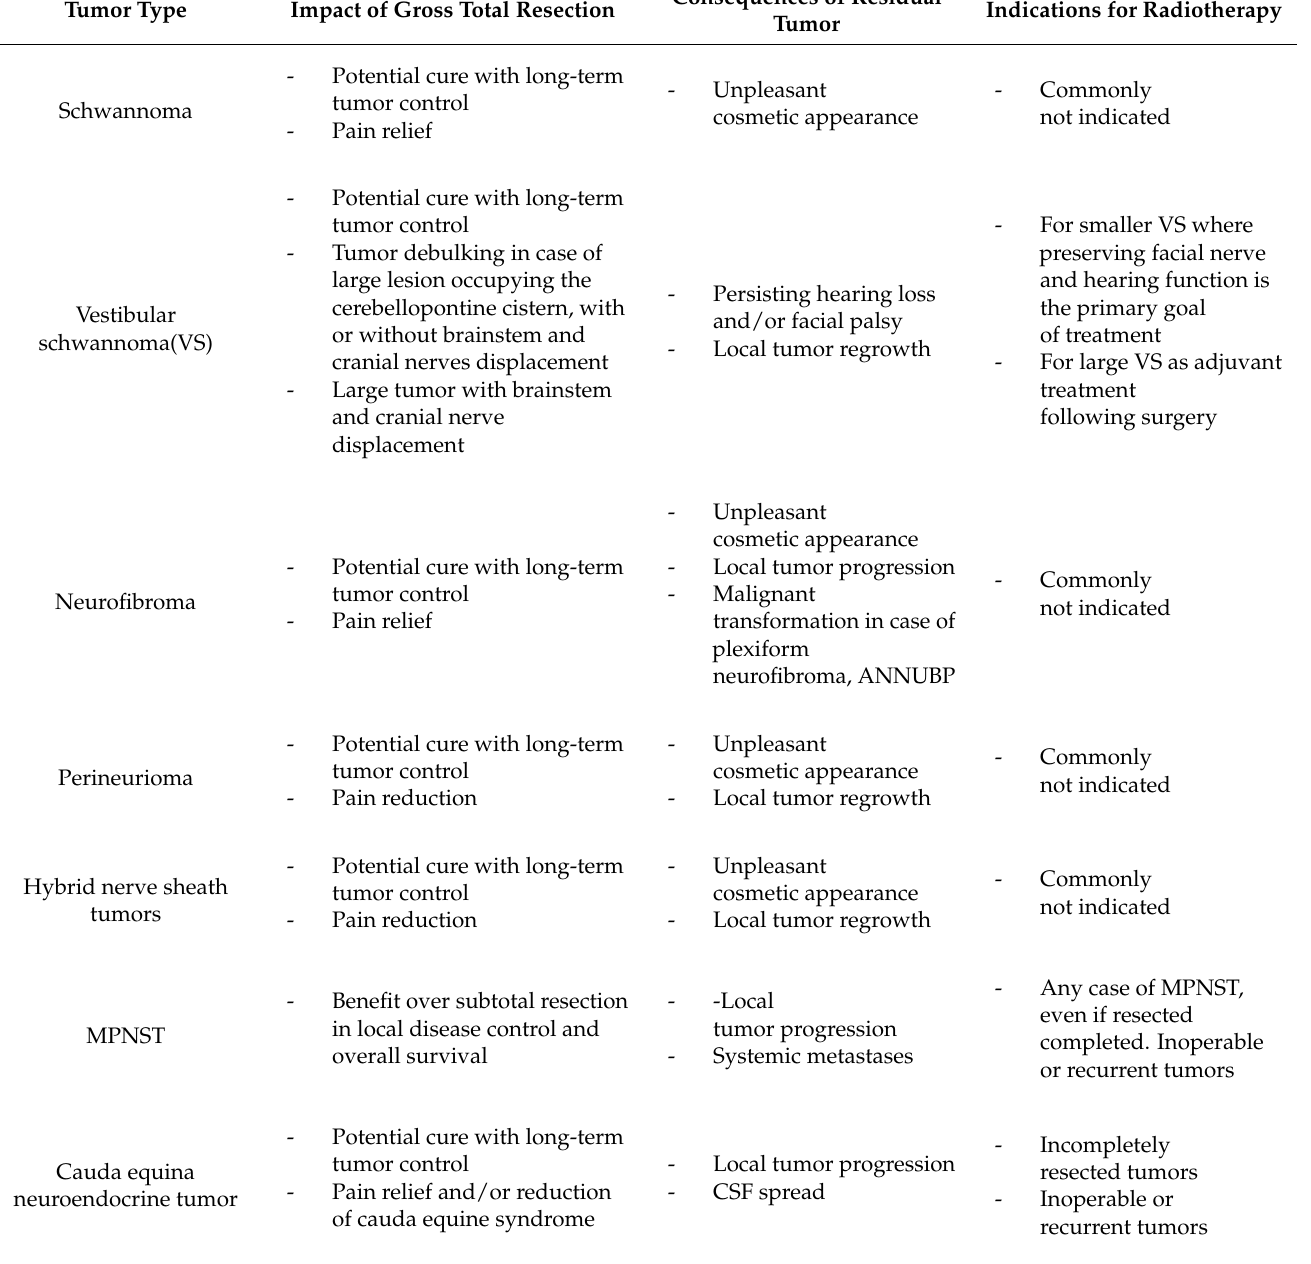
Table 3. Impact of surgery on outcome (gross total vs. partial